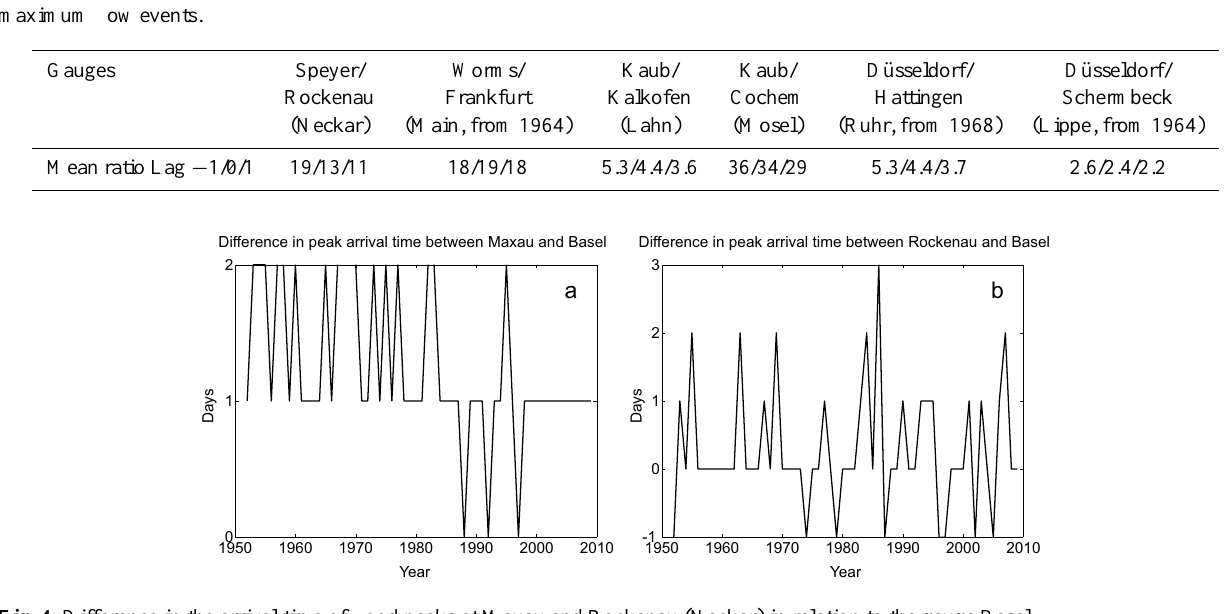
Fig. 4. Difference in the arrival time of flood peaks at Maxau and Rockenau (Neckar) in relation to the gauge Basel.